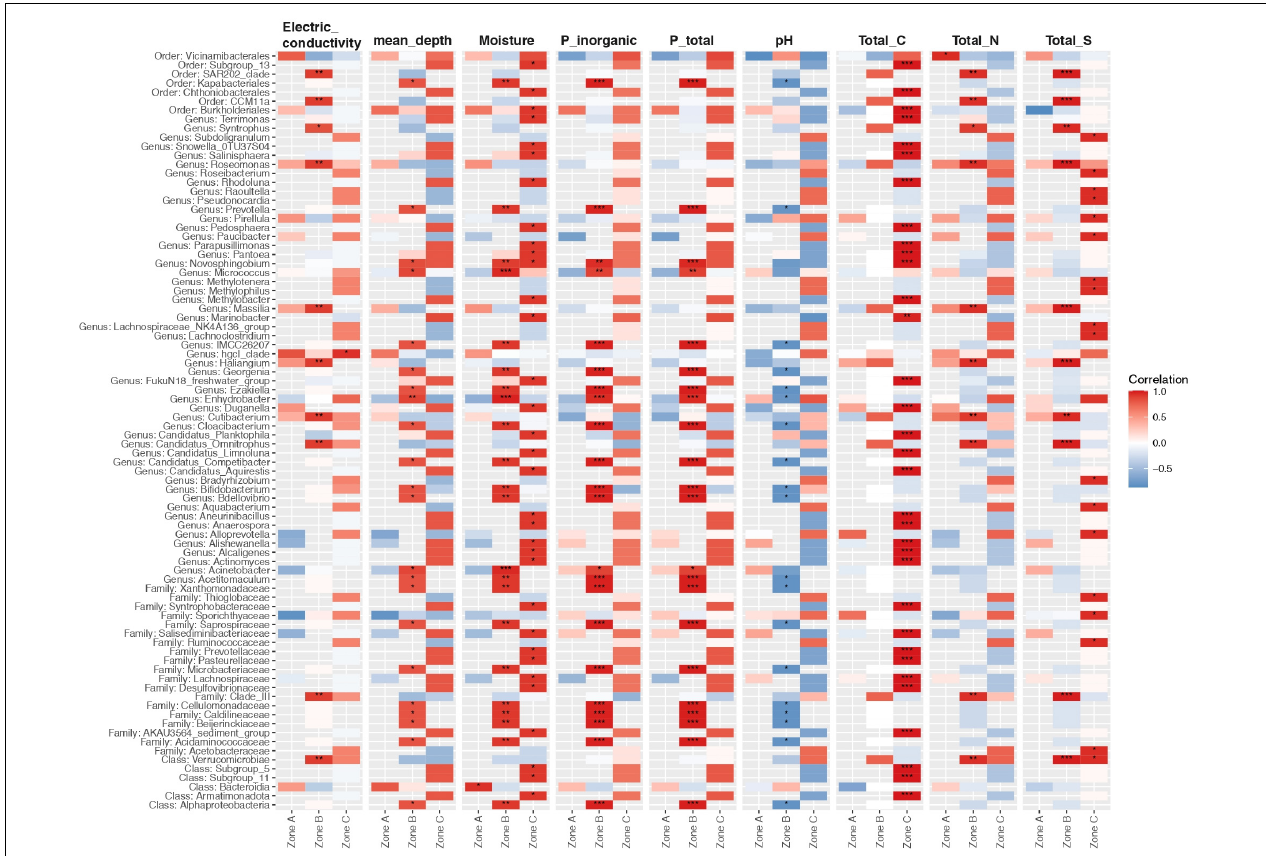
FIGURE 7 | Relationship between the 50 most correlated taxa and soil variables grouped by soil zone. Asterisks show the level of significance (* p value < 0.05, ** p value < 0.01, *** p value < 0.001; Pearson correlation). Comparisons were adjusted for multiple testing using the Benjamini-Hochberg correction. Red, blue, and white indicate positive, negative, and no correlation, respectively. Taxa represent the best-hit taxonomic